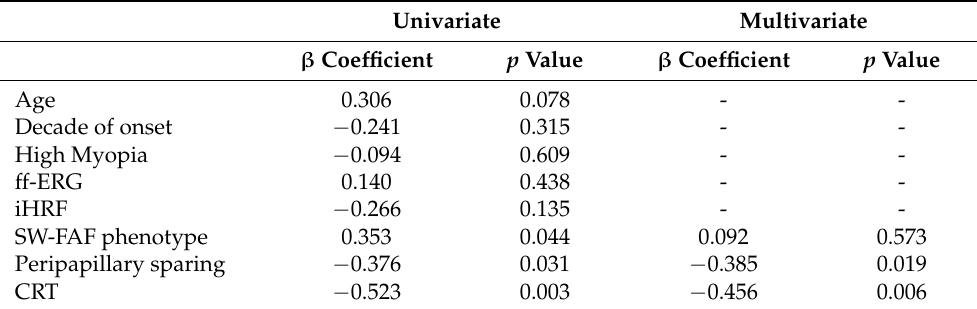
Table 4. The stepwise linear regression analysis investigating the association between the best corrected visual acuity and several parameters included in the